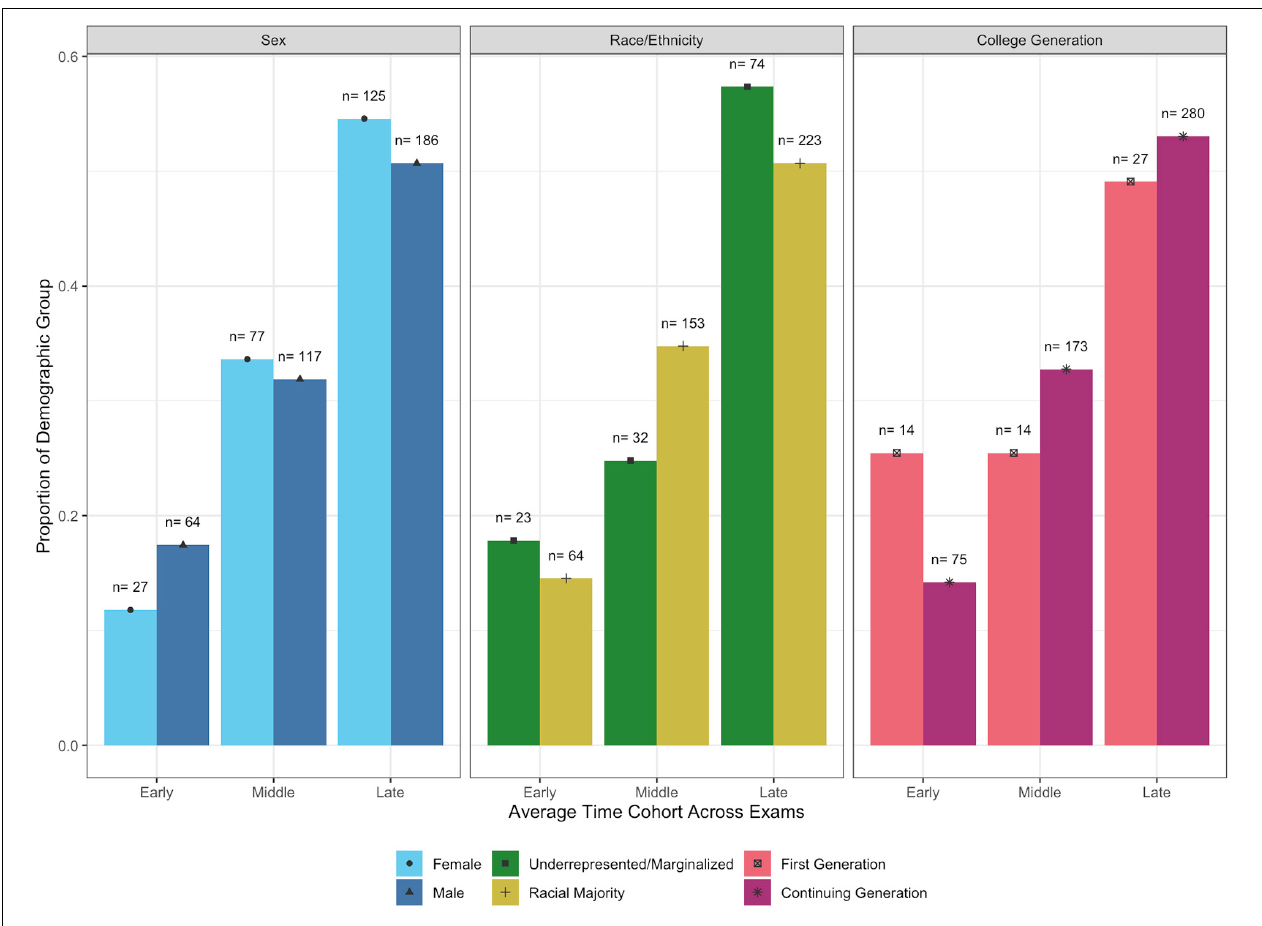
FIGURE 6 | Proportion of demographic group by average time